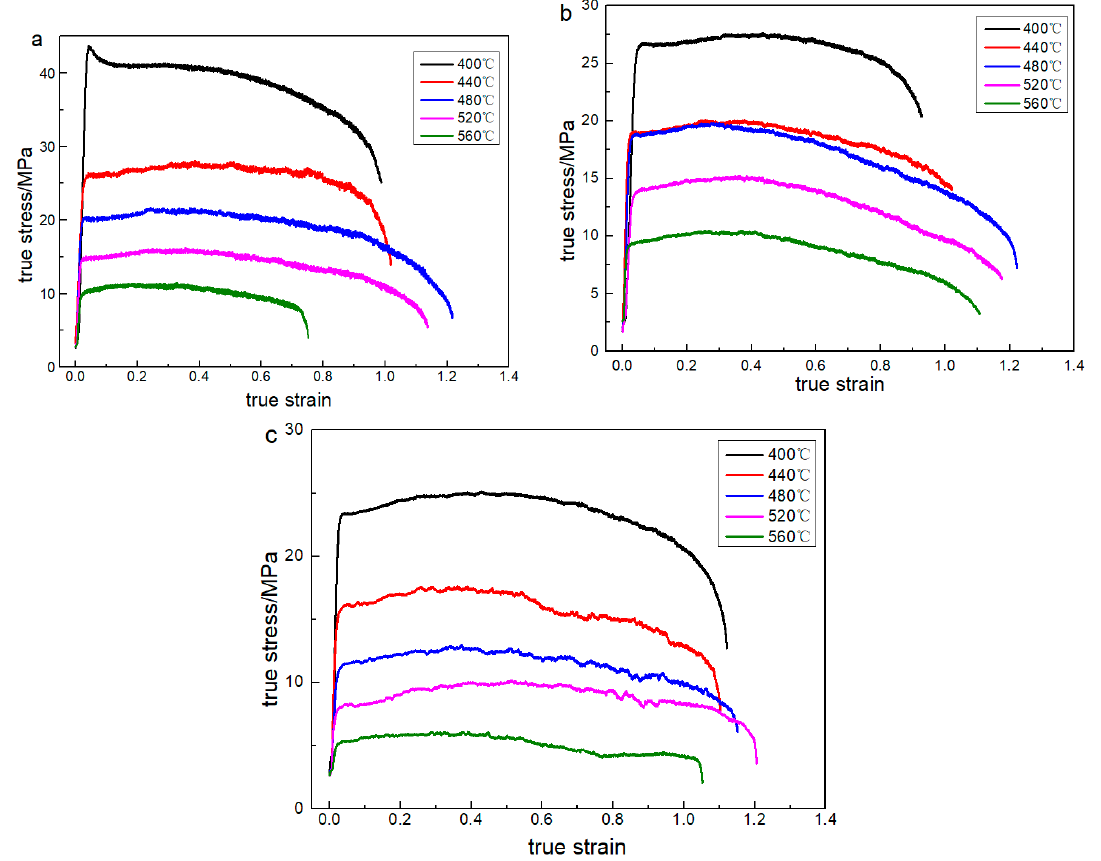
Figure 2. Flow stress curves of AA5083 at: ( a ) 0.005 s − 1 ; ( b ) 0.001 s − 1 ( c ) 0.0005 s − 1.